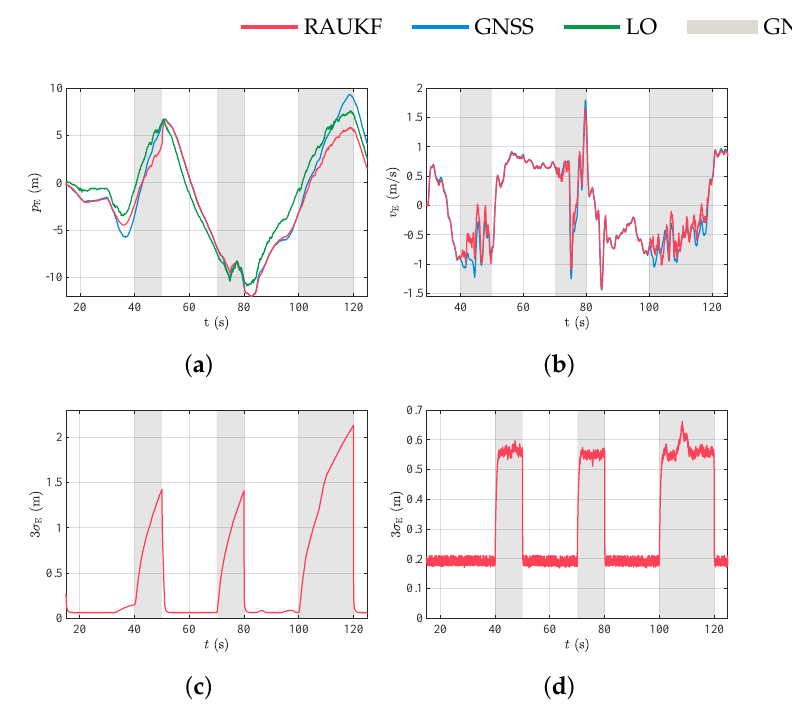
Figure 12. State estimation results. ( a ) Position and ( b ) velocity in the East direction; ( c , d ) three (cid:113) P xx standard deviation σ E = of position and velocity estimates in the east k , ii